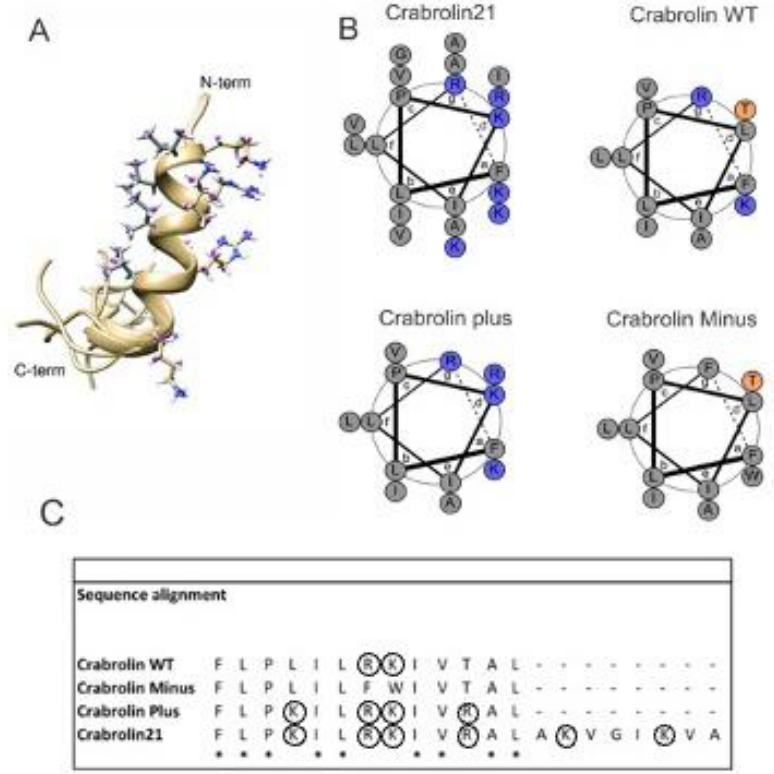
Figure 5. Solution structure of crabrolin21 and comparison with previous crabrolin peptides. ( A ): NMR solution structure of crabrolin21 peptide in TFE. The family of 10 conformers was obtained by torsion angle dynamics by using the CYANA 3.98 software [28]. The side chains of charged amino acids (arginines and lysines) of the first conformer are shown on the right side, and the hydrophobic side chains are shown on the left side. ( B ): Helical wheels of crabrolin21, crabrolin WT, crabrolin Minus, and crabrolin Plus with the charged residues colored in blue. ( C ): sequence alignment of crabrolin peptides. Conserved residues are marked with an asterisk, and charged residues are circled. Helical wheels were obtained with DrawCoil [35].